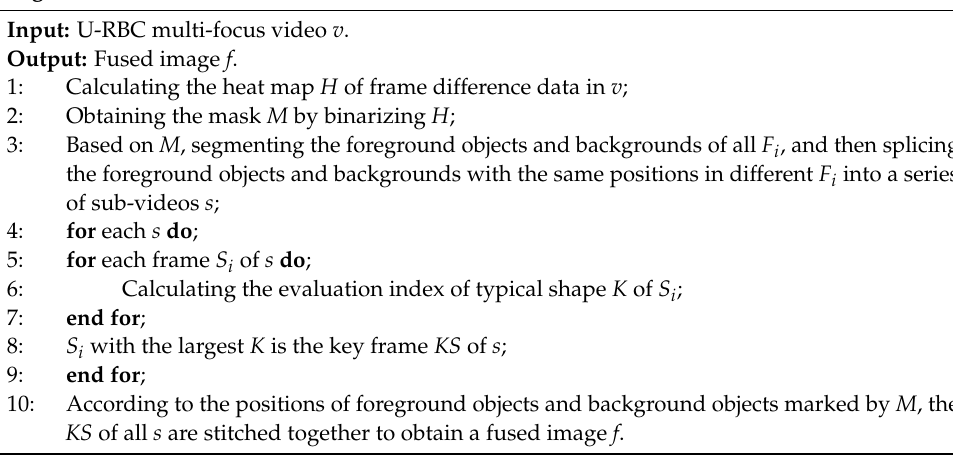
Algorithm 1. Procedure for multi-focus video fusion.